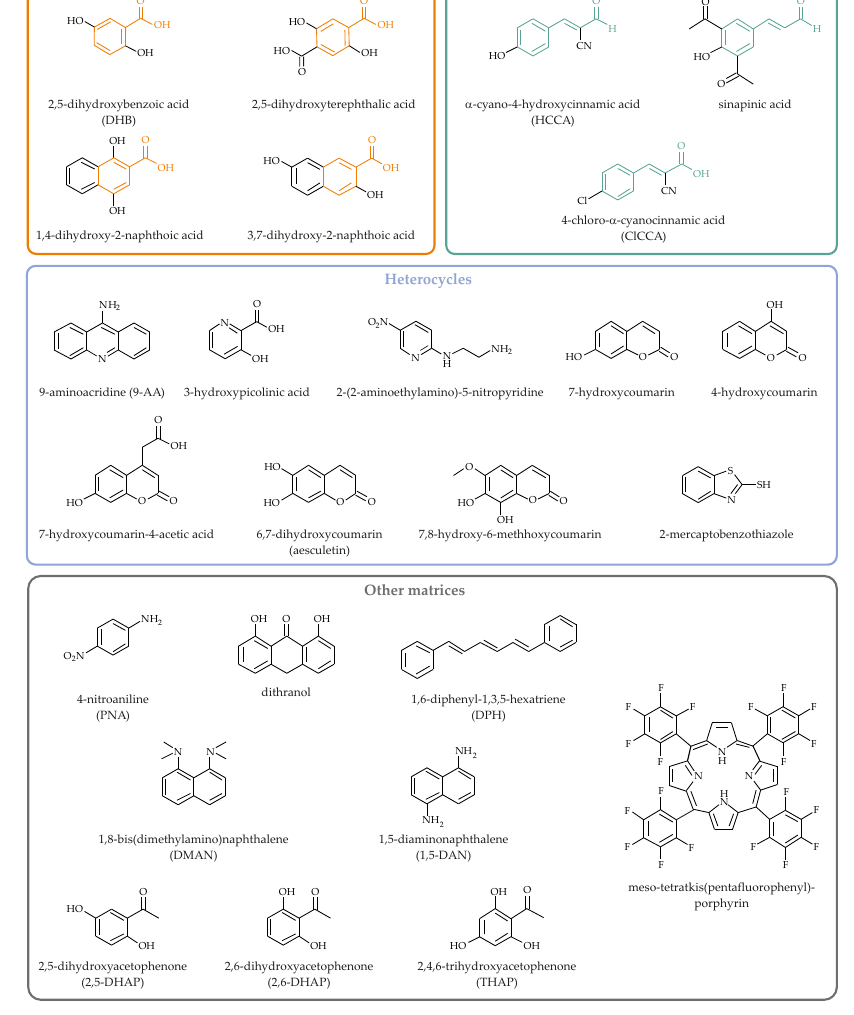
Figure 2. Chemical structures of the organic MALDI matrices which will be explicitly mentioned in this review. The backbones of both benzoic acid (orange) and cinnamic acid (green) derivatives are highlighted. Please note that this is only a small selection and many other compounds were also found to be useful MALDI